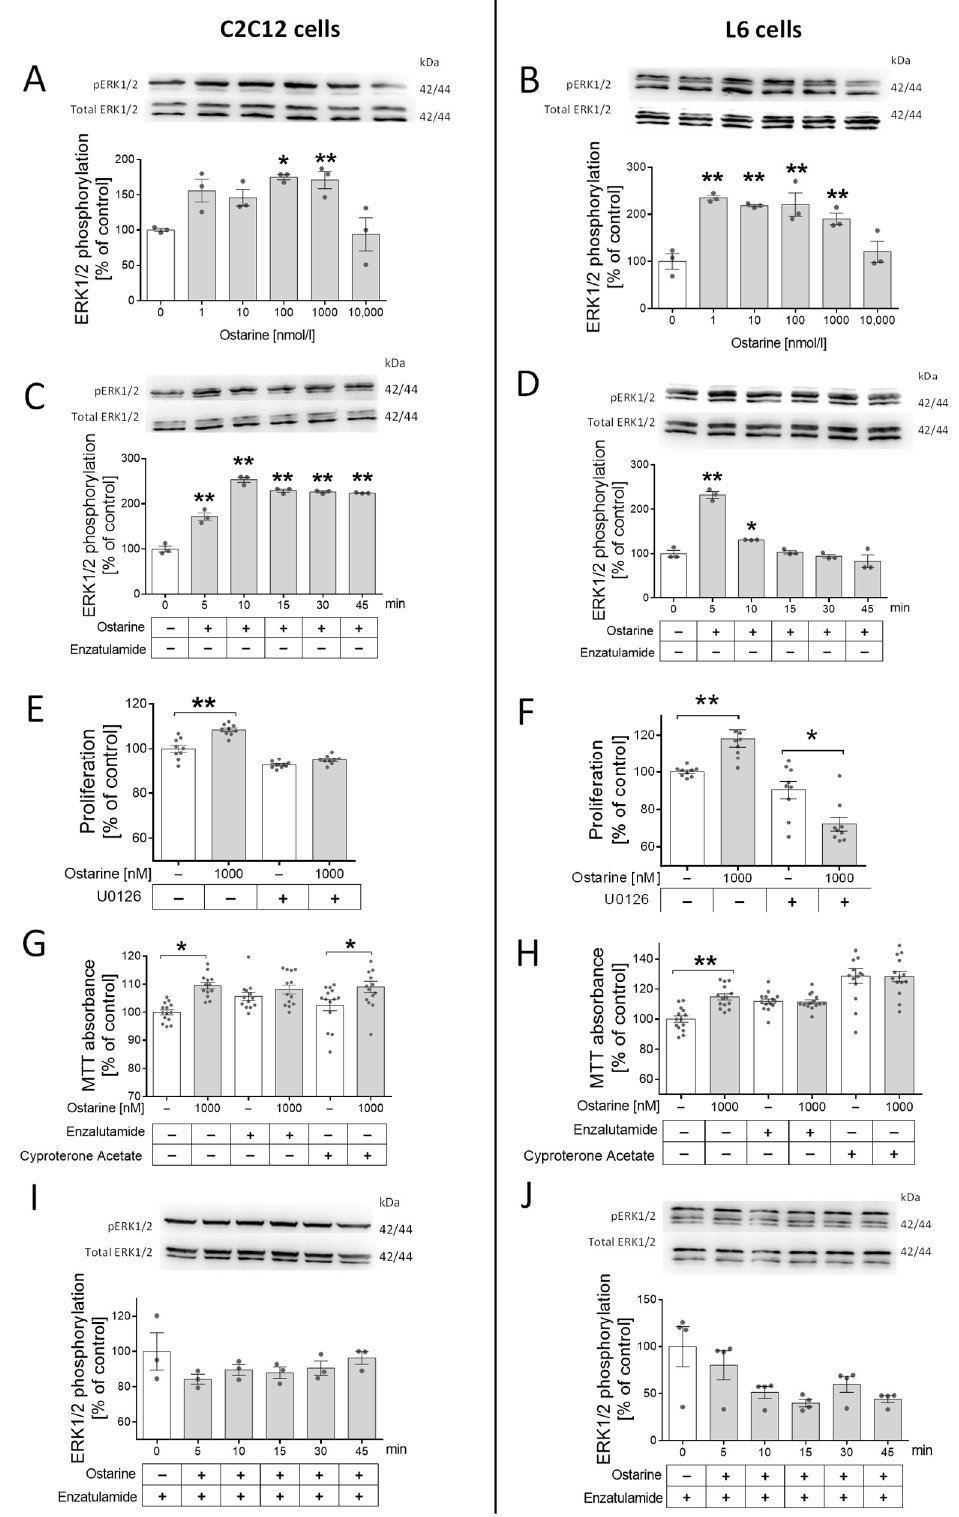
Figure 2. ( A , B ) Effect of different doses of ostarine on ERK1/2 phosphorylation in C2C12 and L6 cells. ( C , D ) Time activation of ERK1/2 phosphorylation by ostarine in C2C12 and L6 cells. ( E , F ) Impact of ostarine and ERK1/2 inhibition on proliferation of C2C12 and L6 cells. ( G , H ) Effect of ostarine and pharmacological AR blocking on viability of C2C12 and L6 cells. ( I , J ) Effect of ostarine on ERK1/2 phosphorylation in the presence of AR blocker enzalutamide in C2C12 and L6 cells. Statistically significant differences are represented as * p < 0.05 and ** p < 0.01 versus corresponding control using one-way ANOVA followed by Dunnett’s post hoc test ( A , B , C , D , I , J ) or unpaired